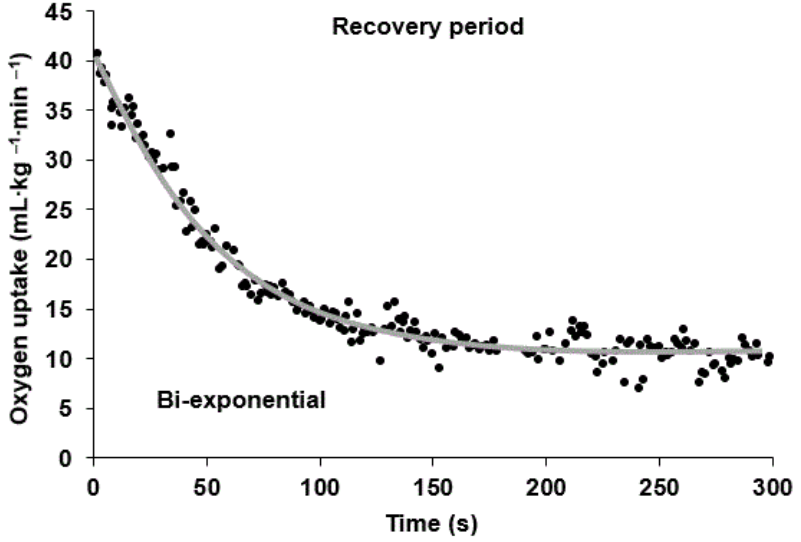
Figure 1. Individual oxygen uptake curve during the recovery period after the Fran workout (bi- exponential model fit).